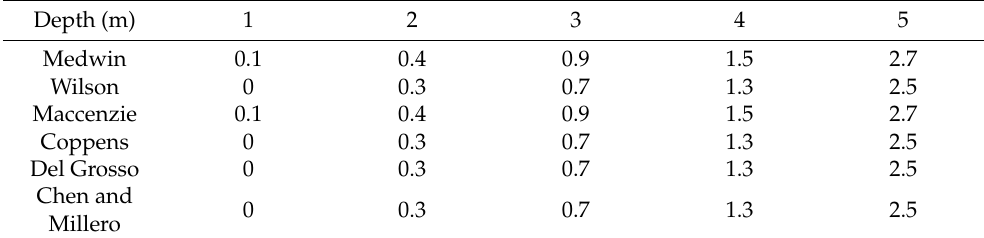
Depth error for measurements in Gda´nsk and Gdynia are shown in Figure